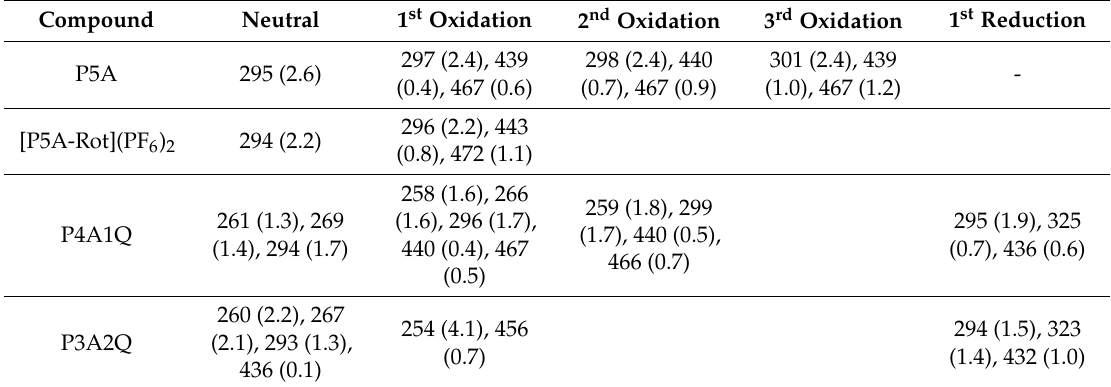
Table 2. UV / vis spectroscopic data. λ abs / nm ( ε x 10 − 3 / mol − 1 dm 3 cm − 1 ) a.